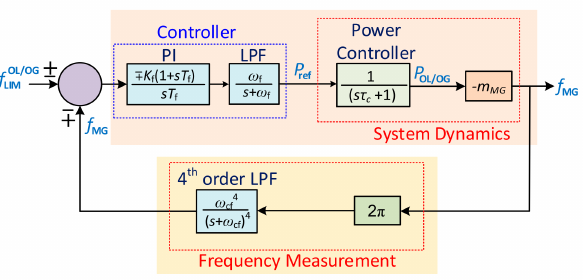
Figure 13. Assumed closed-loop control structure of frequency